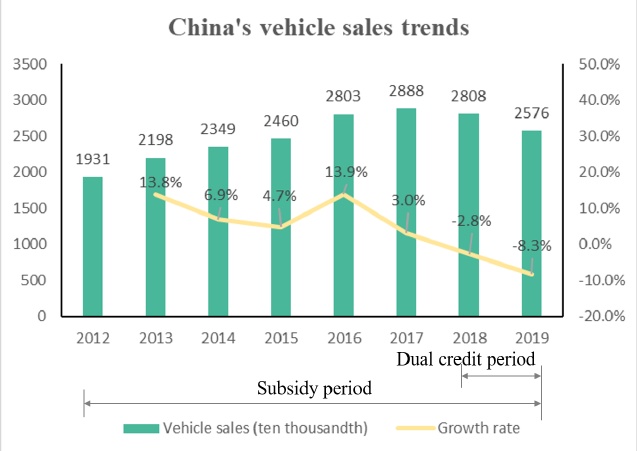
Figure 2. China’s vehicle sales trends. Note: source: China Association of Automobile Manufacturers (http://www.caam.org.cn/english, (accessed on 21 March